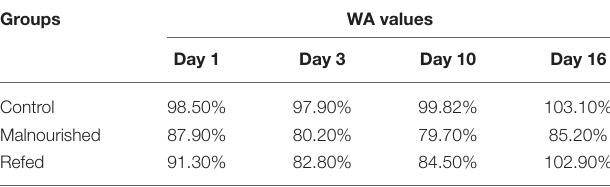
TABLE 2 | Weight-for-age relationship (WA) value.